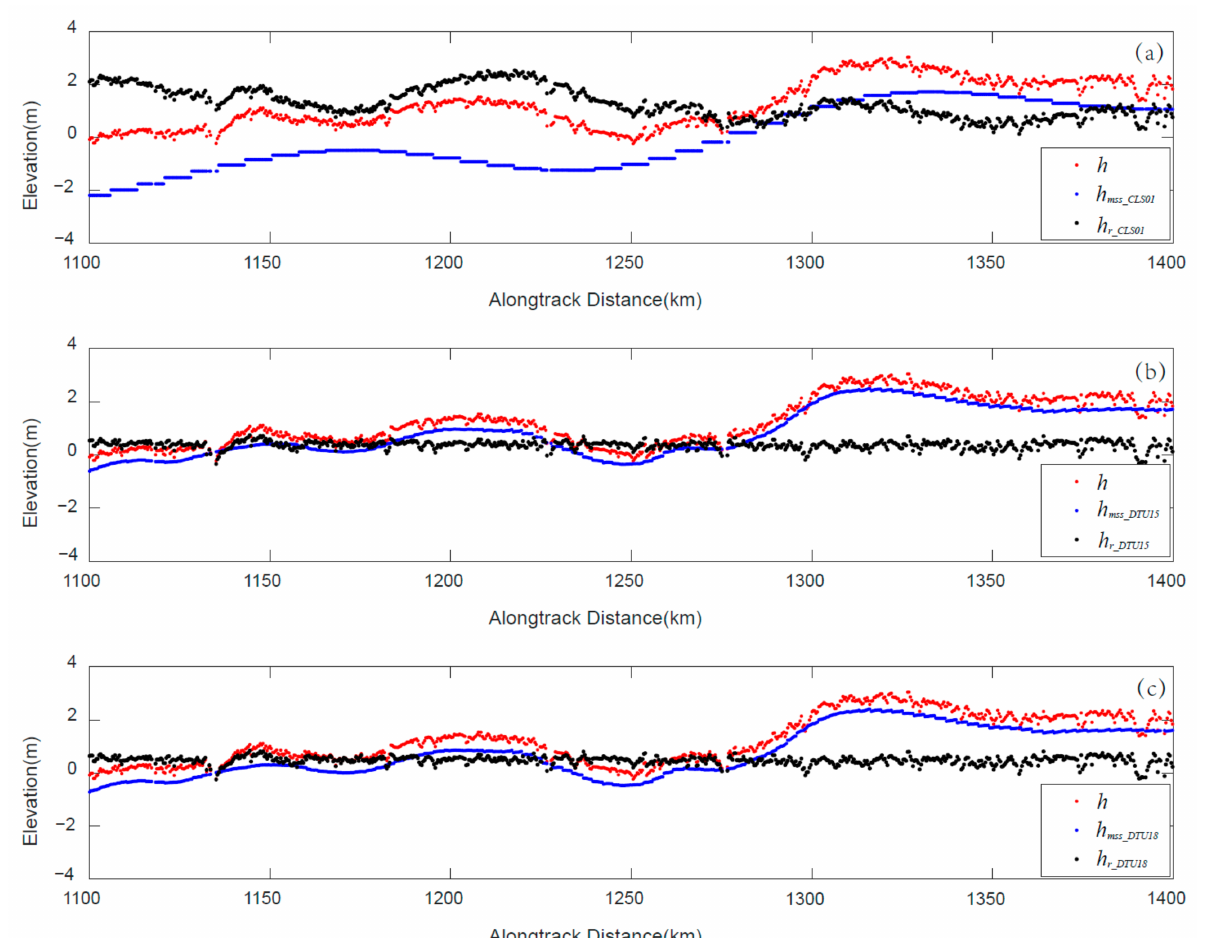
Figure 2. A sample of Envisat elevation profiles over the Arctic Ocean. The red points in ( a – c ) represent the reference elevation to the WGS84 ellipsoid. The blue points in ( a – c ) represent the mean sea surface height from CLS01, DTU15 and DTU18, respectively. The black points in ( a – c ) represent the relative elevations with CLS01, DTU15 and DTU18, respectively.